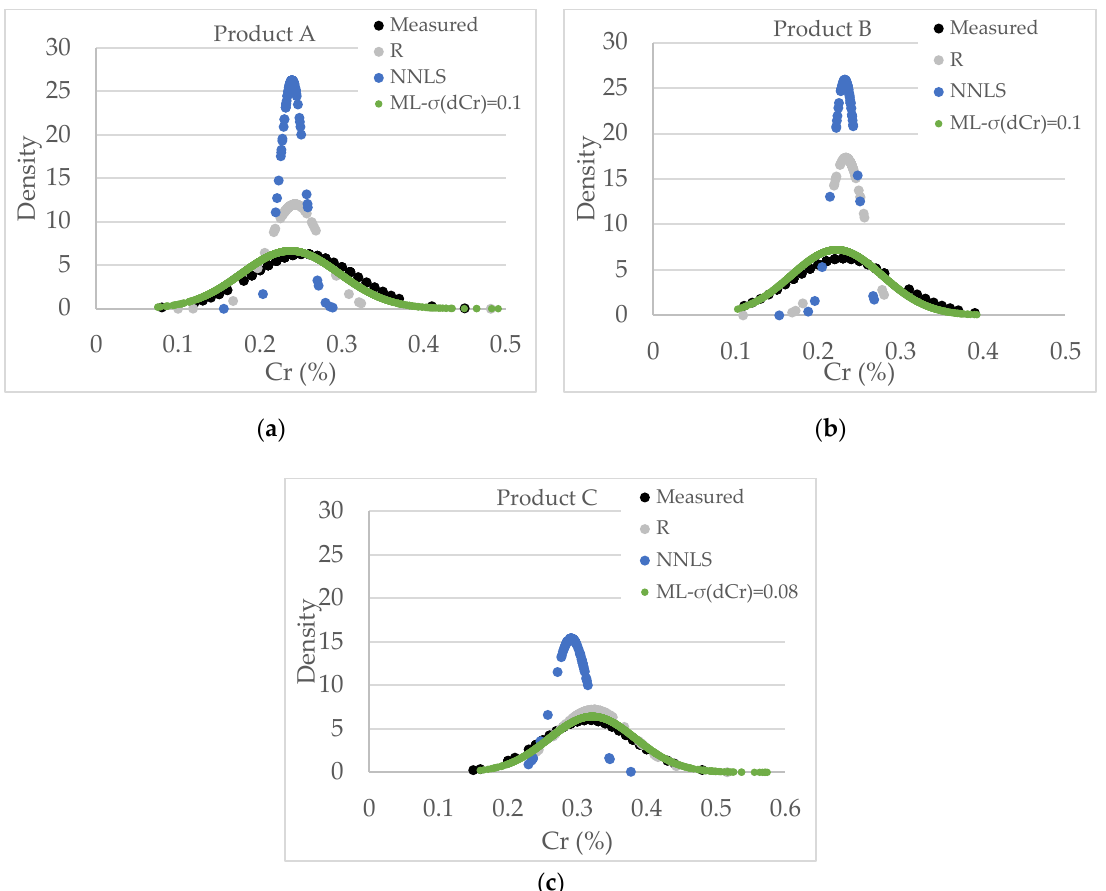
Figure 8. Comparison between the concentration of Cr calculated using the reported scrap composition (R) and the calculated scrap composition using the NNLS and ML methods. Data are given for three target products: A, B and C, ( a–c ).